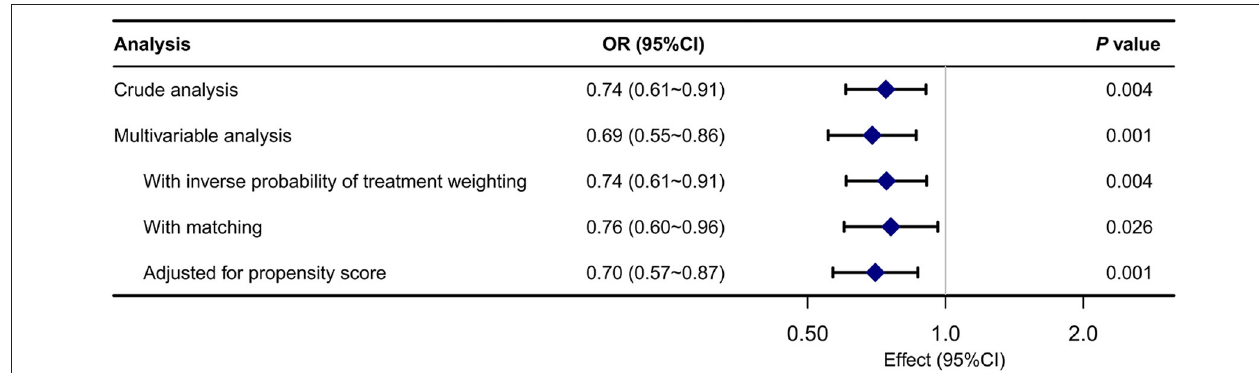
FIGURE 3 | Associations between ABG analysis and the outcome in the crude analysis, multivariable analysis, and propensity-score analyses.